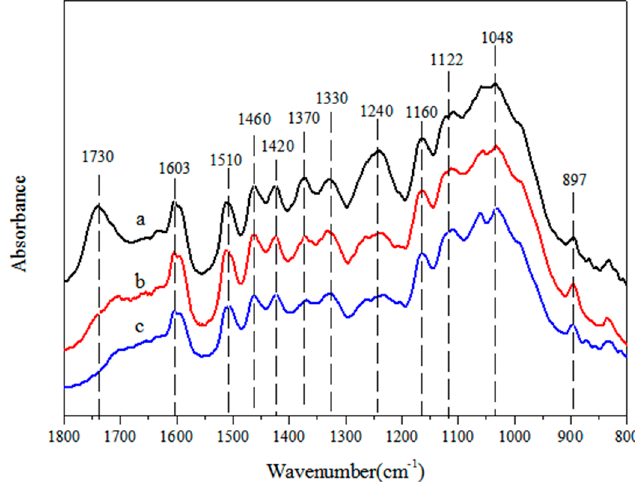
Figure 2. Fourier-transform infrared (FTIR) spectra of used BGP and control samples. ( a ) Control samples; ( b ) BGP collected from Fujian Province (FJBGP); ( c ) BGP collected from Shandong Province (SDBGP).